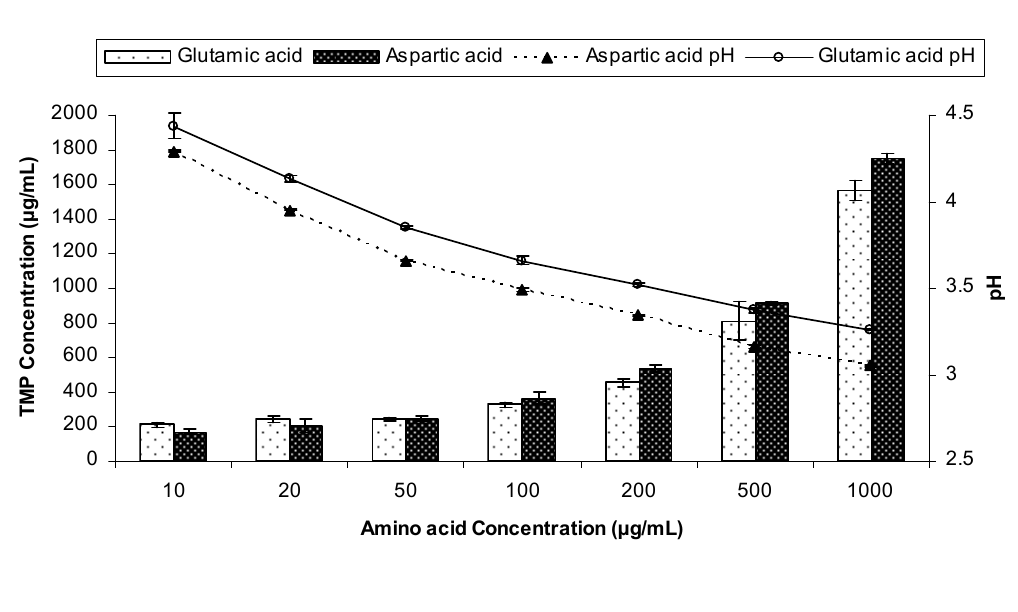
Figure 2. Phase solubility diagram of Trimethoprim (TMP) in the presence of different concentrations of glutamic acid and aspartic acid at different pH (n =